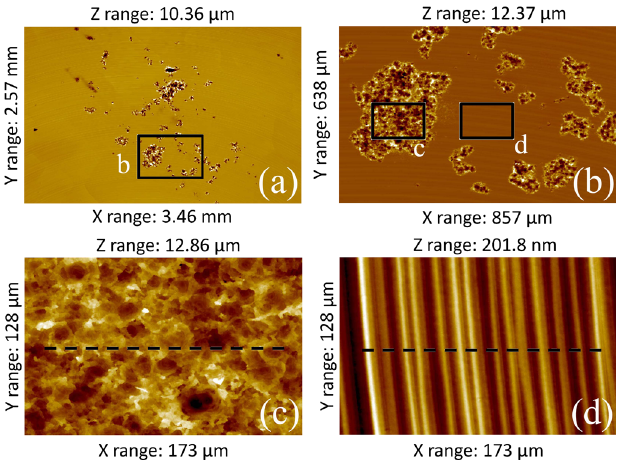
FIG. 7. Cathode surface morphology measured by a white light interferometer, and rms roughnesses are (a) 233 nm, (b) 653 nm, (c) 1420 nm, and (d) 36.5 nm.